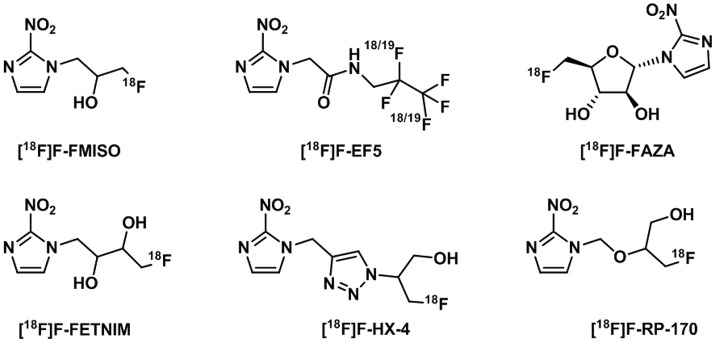
Structures of 18F-nitroimidazoles translated into the clinic (Challapalli et al., 2017).